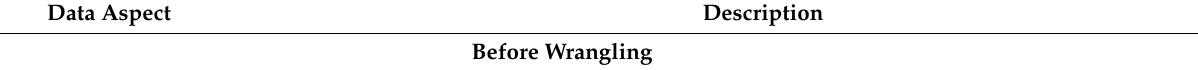
Figure 3. Data analysis steps.